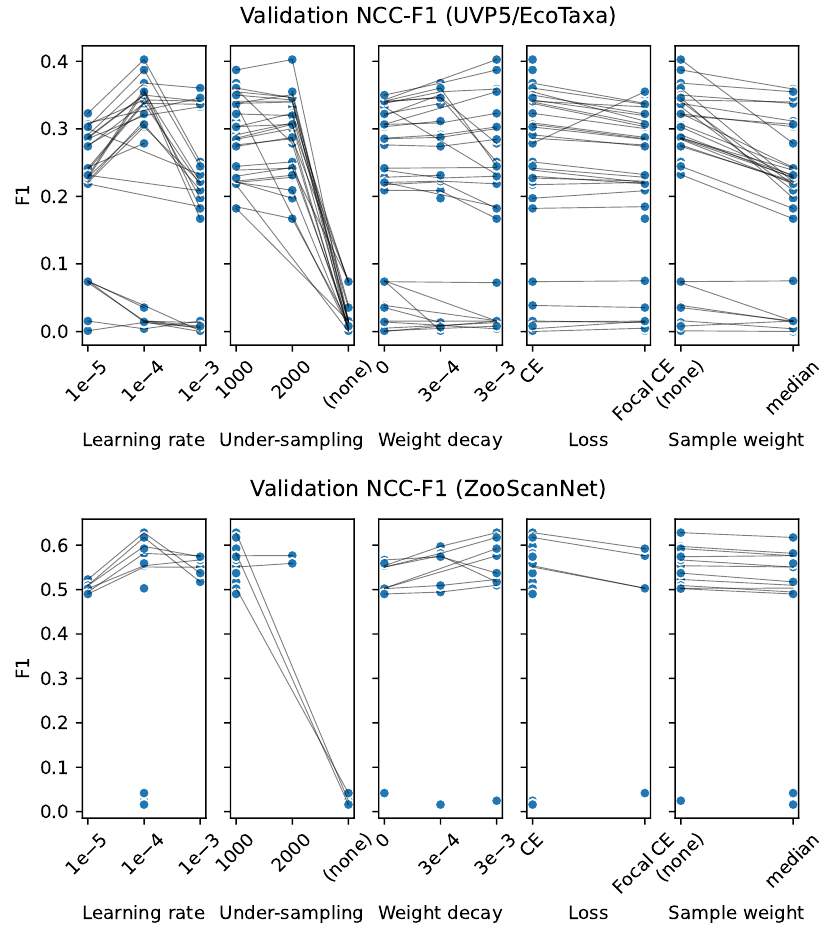
Figure A4. Dependence of the validation NCC-F1 for supervised learning on under-sampling, loss, weight decay, learning rate and sample weighting for the UVP5/EcoTaxa ( top ) and the ZooScanNet ( bottom )